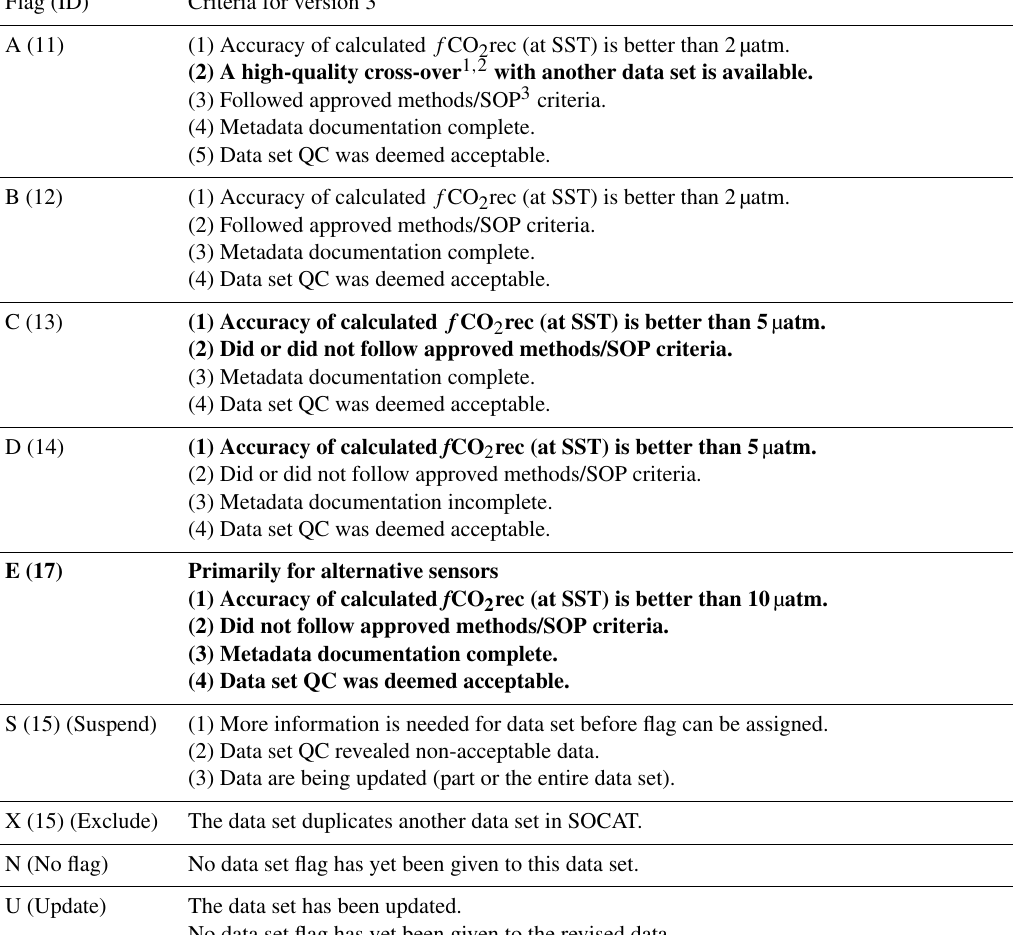
Table 2. Data set quality control (QC) flags in version 3 (Wanninkhof et al., 2013b; Olsen et al., 2015). All criteria need to be met for assigning a flag of A to E. Data sets with flags of A to E have been made public. Data sets with a flag of A to D are included in the global synthesis and gridded products (Table 8). Changes relative to versions 1 and 2 are in bold. Flag (ID) refers to the data set quality control flag with its numerical identifier (ID) provided between brackets. Calculation of “recommended f CO 2 ” ( f CO 2 rec) is explained in Sect.